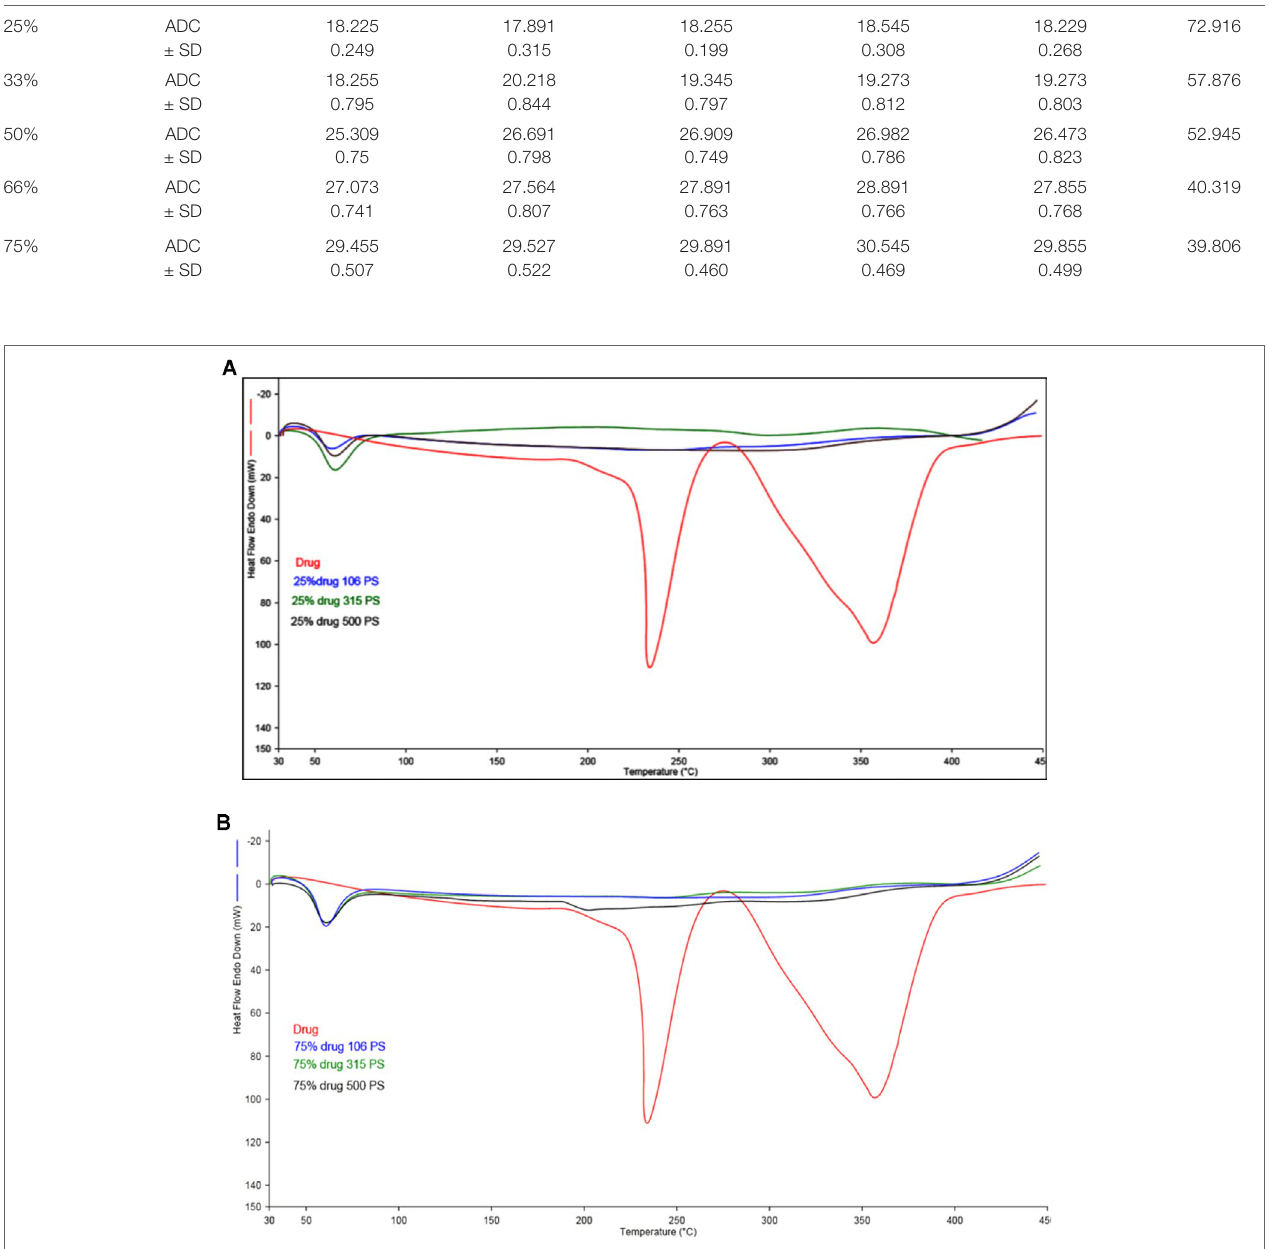
FIGURE 2 | (A) DSC scan of different particle size of Span 60 microparticles containing drug prepared by using 25% theoretical drug content (TDC). (B) DSC scan of different particle size of Span 60 microparticles containing drug prepared by using 75%